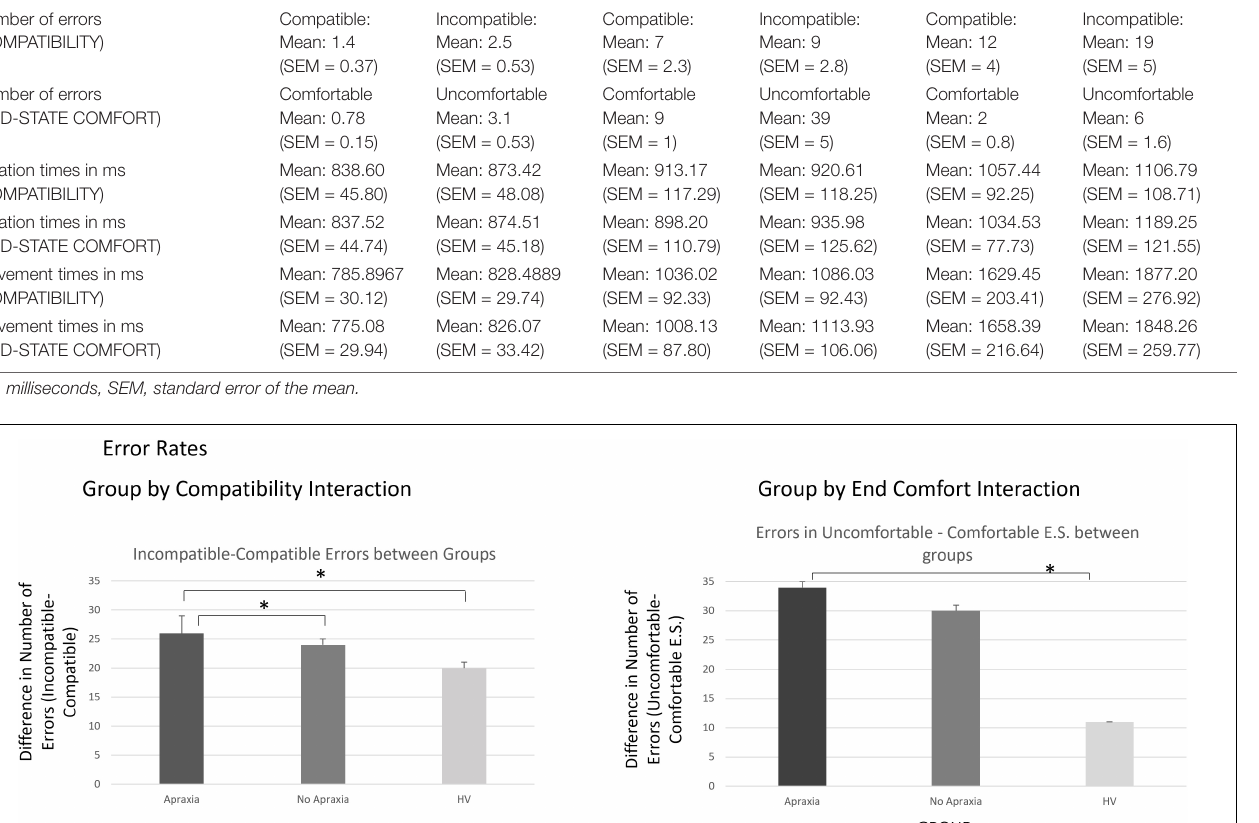
Patients without apraxia (12 participants)